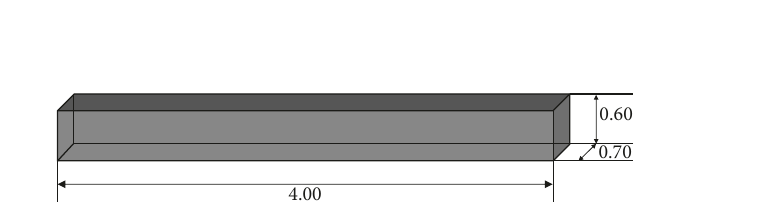
Figure 8: Paste fluidity test